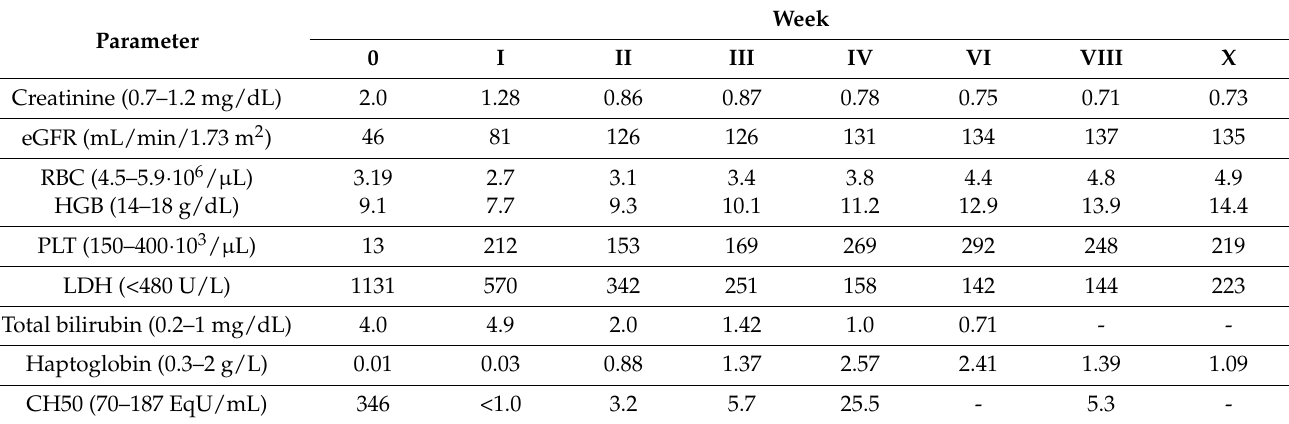
Table 1. Laboratory parameters of patient no. 1 over time after drug administration.